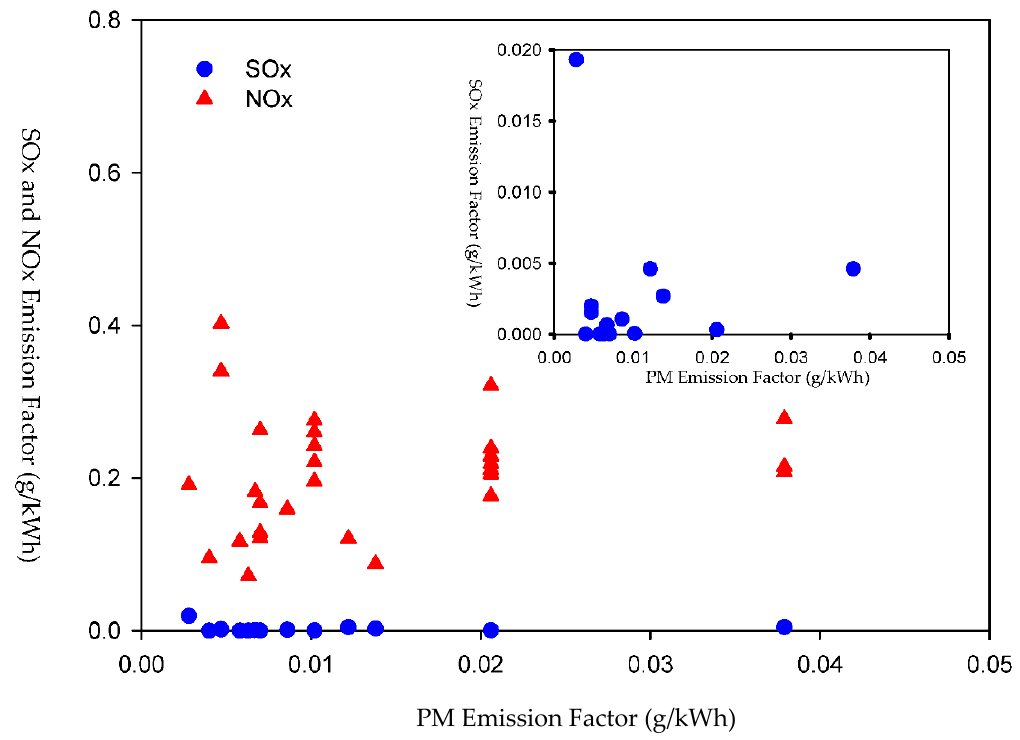
Figure 7. Relationships among PM, SOx, and NOx emission factors for LNG-fueled power generation units.